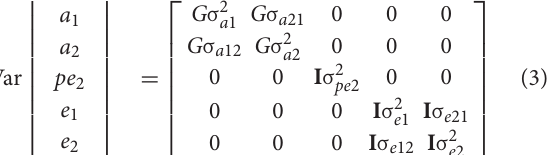
Figure 3 . The heritability increased with averaging of the four measurements from h 2 = 0.40 for Lipid DSRep with no averaging to h 2 = 0.53 for Lipid DSRepLR when averaging left and right sides to h 2 = 0.59 for Lipid DSAve when all four measurements are averaged. Similarly, repeatability increased from t 2 = 0.56 with Lipid DSRep to t 2 = 0.80 for Lipid DSRepLR . Interestingly the genetic correlation to Lipid True was very consistent irrespective of averaging r g = 0.96–0.97. The phenotypic correlations to Lipid True (after linear absorption of fixed effects) were the lowest for single body site measurements r p = 0.46–0.53, but similarly increased with averaging of measurements from 0.60 for Lipid DSRep to 0.66 for Lipid DSAve